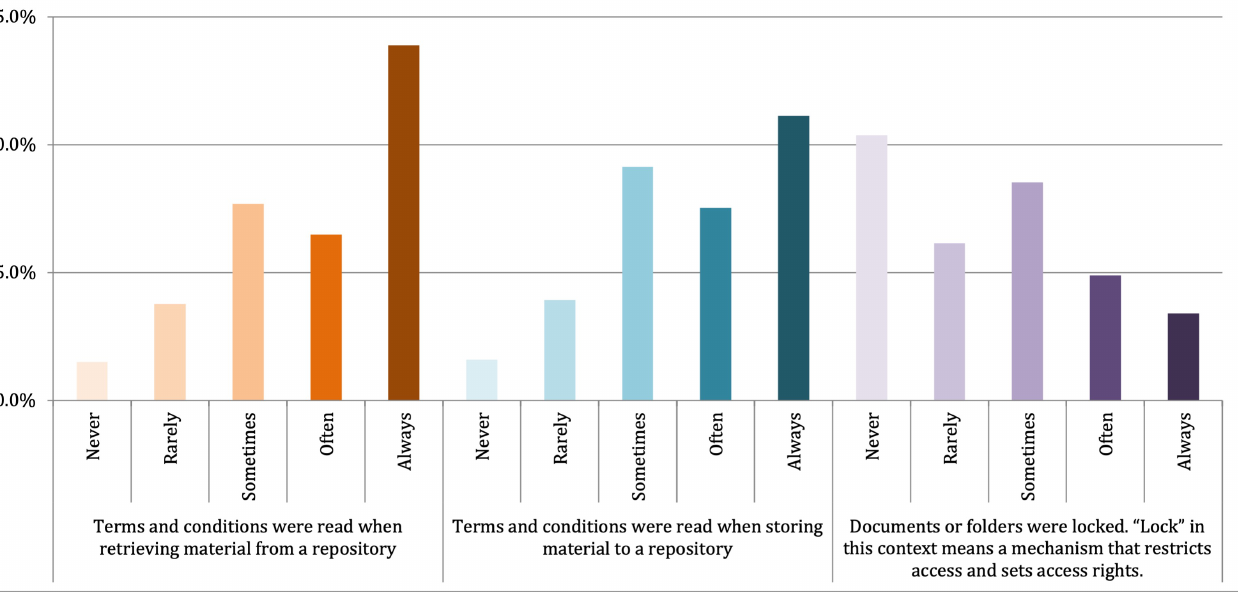
Figure 4. Indonesian scientists’ behavior in handling digital